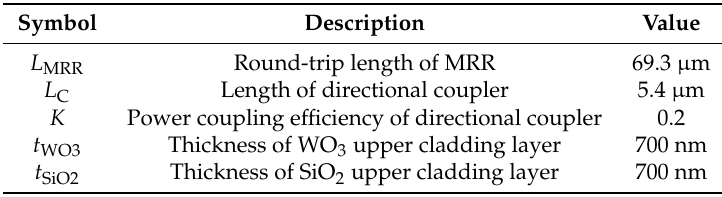
Table 1. Device parameters of MRR sensor.